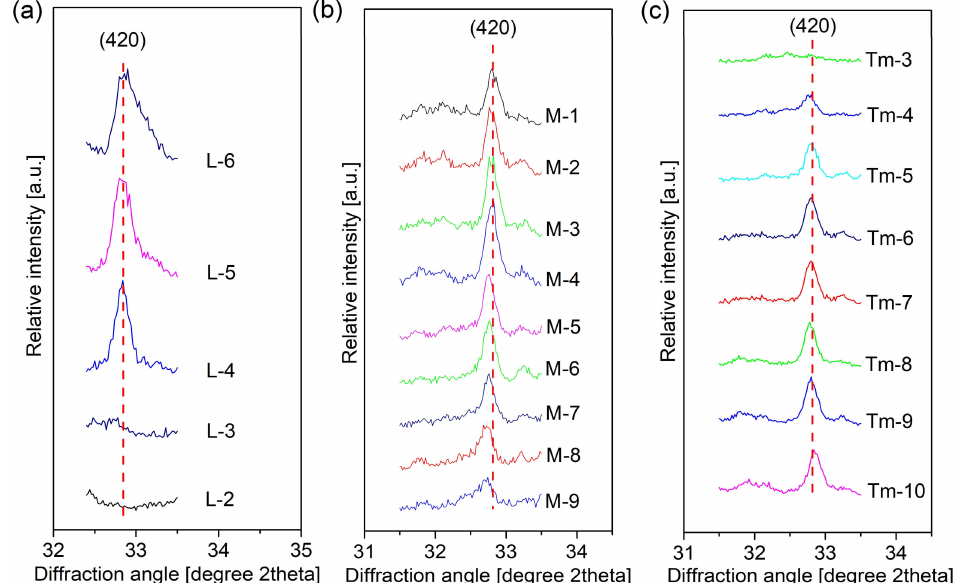
Figure 5. Diffraction peak from hydrogarnet (420) with various hydrothermal conditions: ( a ) reaction temperature; ( b ) Ca/Si molar ratio (N Ca/Si ); ( c ) reaction time (data of Tm–3 to Tm–10 were from the previous publication